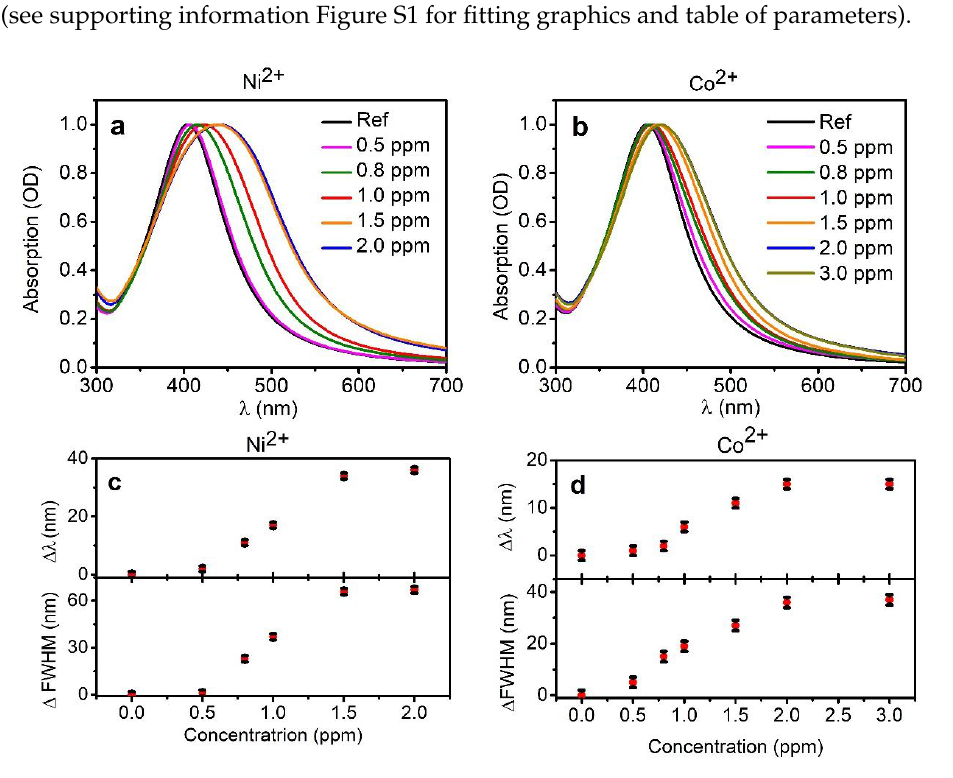
Figure 1. Optical absorption bands for Ni 2+ ( a ) and Co 2+ ( b ) as a function of the ion concentration (reported in the figure labels); variation of Δλ and variation of the full width at half maximum (ΔFWHM) of Ni 2+ ( c ) and Co 2+ ( d ), as a function of the ion concentration.